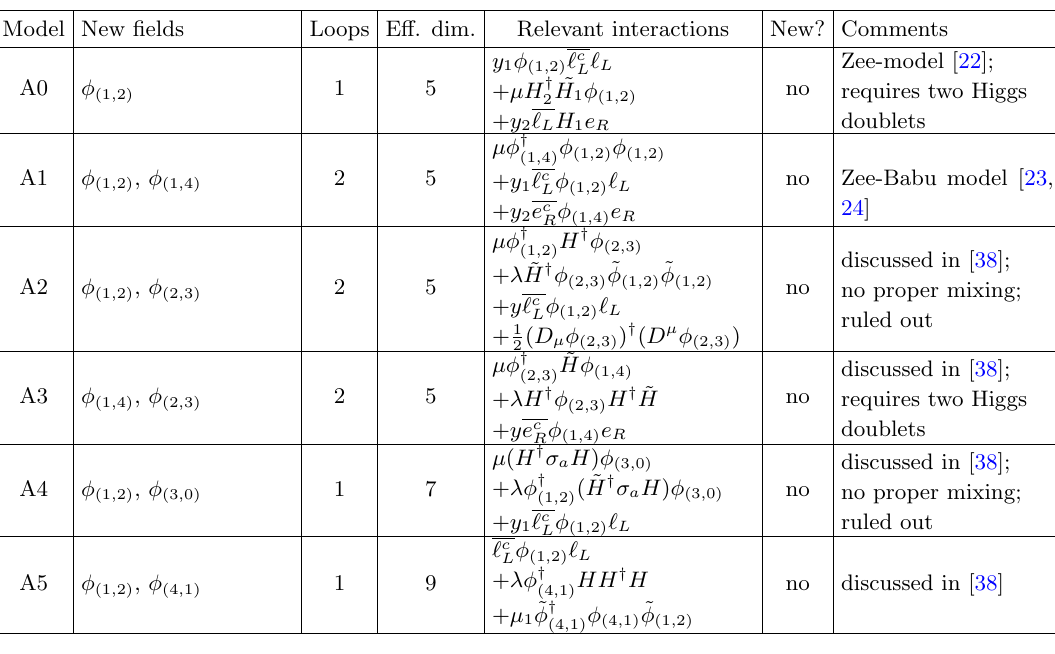
Table 2 . Radiative neutrino mass models with two scalars without